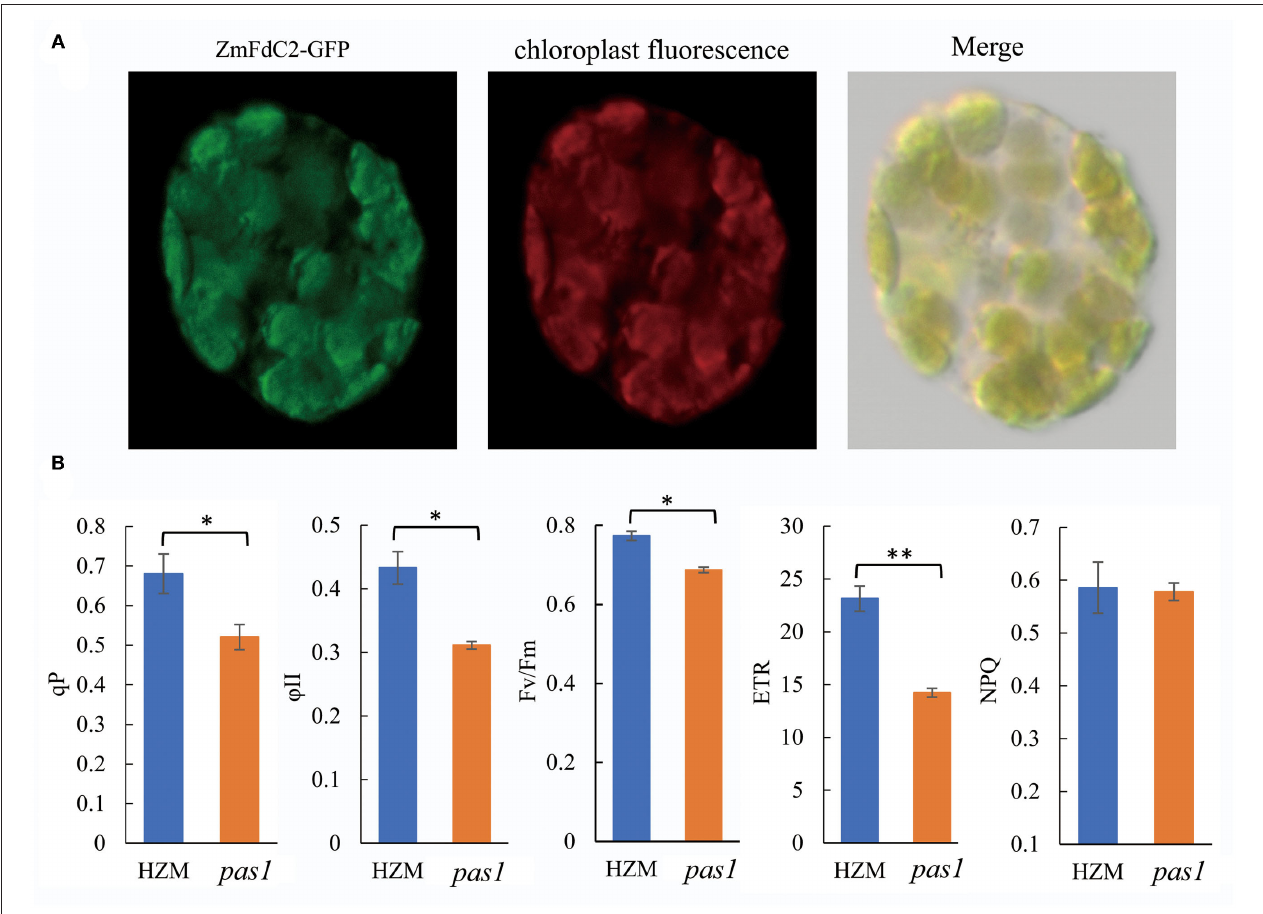
FIGURE 3 | Chloroplast localization of ZmFdC2 and photosynthetic electron transport parameters of HZM and pas1 mutant. (A) . Subcellular localization of ZmFdC2-GFP. ZmFdC2-GFP plasmid was transformed into maize protoplast, and fluorescence was detected with confocal microscopy. Left, ZmFdC2-GFP; middle, chloroplast autofluorescence; right, overlay of GFP and chloroplast signals. (B) , Photosynthetic electron transport parameters of HZM and pas1 mutant. Chlorophyll fluorescence parameters for PSII capacity ( φ II), the photosynthetic electron transfer rate (ETR), photochemical quenching (qP), and non-photochemical quenching (NPQ) were determined. Values are mean ± S.D. of at least six independent measurements. Significances were determined with Student’s t-test . “*” indicates p < 0.05 and “**” indicates p <